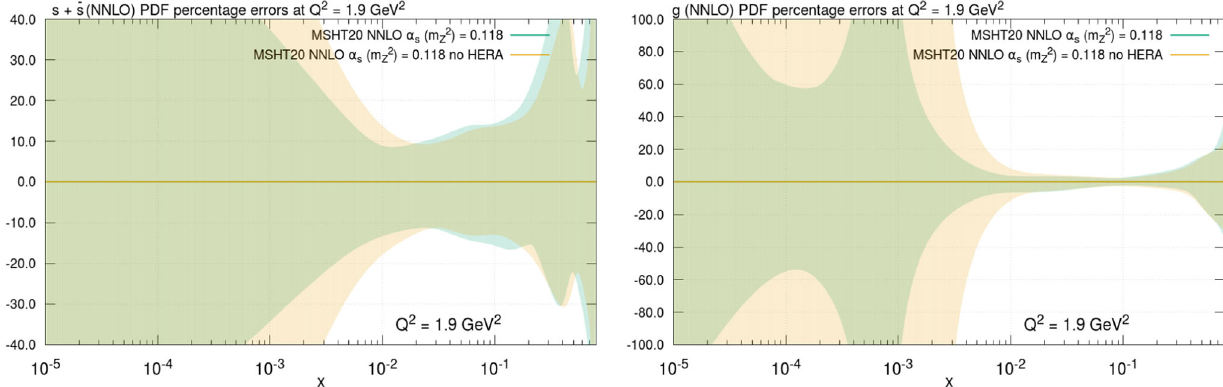
Fig. 78 (Left) s + ¯ s PDF and (right) g PDF percentage errors at Q 2 = 1 . 9 GeV 2 at NNLO showing the effect of removing the HERA data from the MSHT20 default global